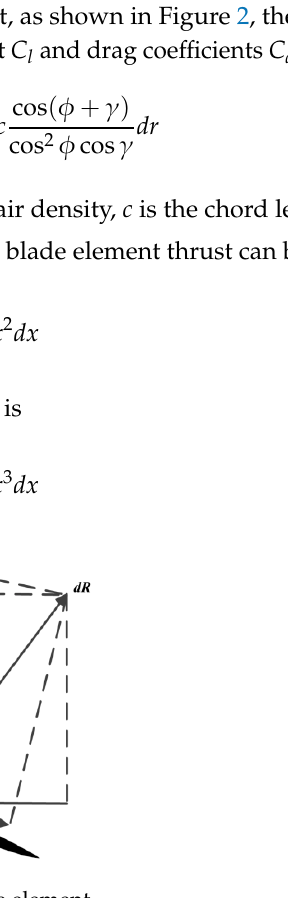
Figure 2. Force analysis of a blade element.